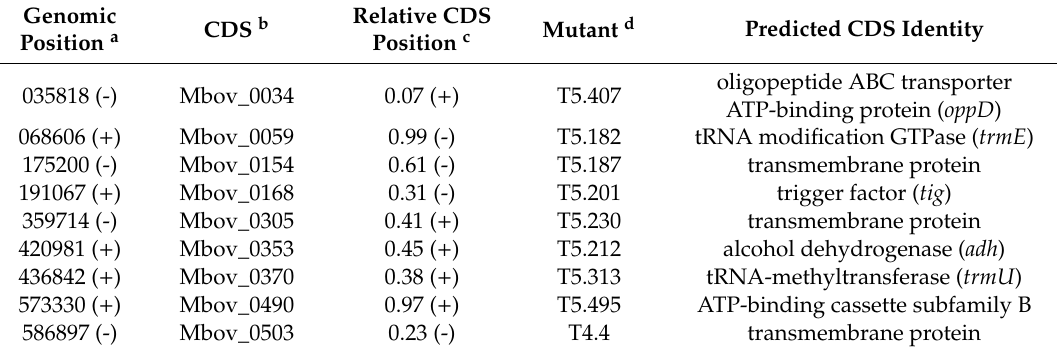
Figure 1. M. bovis mutants with altered binding properties. ( A ) Binding of M. bovis mutants to EBL cells. For each mutant, the binding to EBL cells was determined by counting the number of CFU associated with cell monolayers following incubation with 10 8 CFU. Data are mean mycoplasma titers from three independent assays. Standard deviations are indicated. ( B – D ) Adhesion of HB0801 and Mbov_0503 knock-out mutant T4.4 to EBL cells. ( B ) Influence of the temperatures on the binding capacity. For each mycoplasma strain, the binding to EBL cells was determined by counting the number of CFU / mL associated with cell monolayers following incubation with 10 8 CFU. Data are mean mycoplasma titers from three independent assays. Standard deviations are indicated. ( C ) Quantification of M. bovis binding to EBL membrane proteins. Microplates were coated with 100 ng or 200 ng EBL membrane extracts; 10 7 CFU of each strain were used. ( D ) Visualization of CFDA-SE labeled mycoplasmas bound to EBL cells by laser scanning confocal microscopy. Actin filaments and nuclei were labeled with control (MOCK). Table 2. Transposon insertion sites in M. bovis mutants with reduced binding to EBL cells